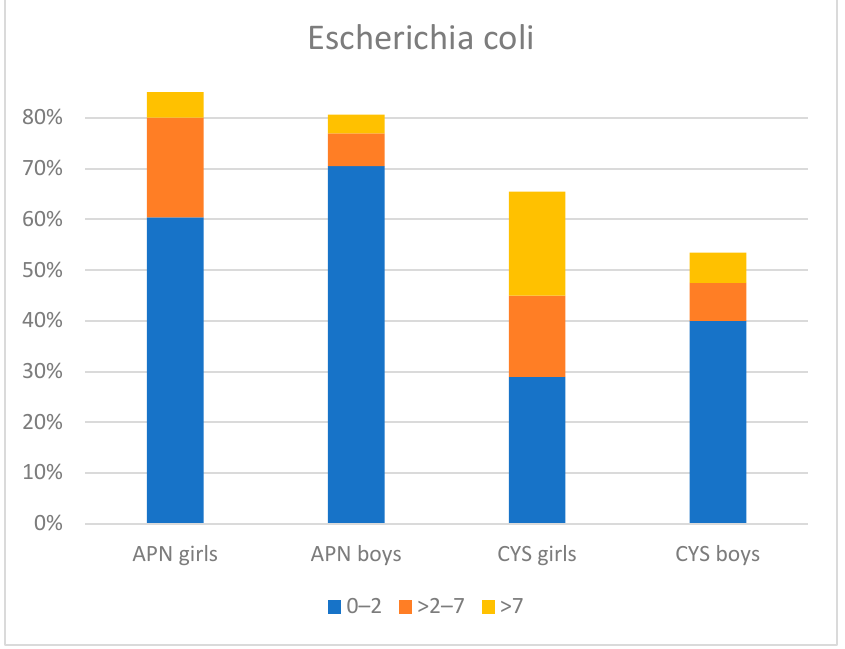
Figure 3. Distribution of E. coli strains according to sex, age, and type of UTI. APN; acute pyelonephritis, CYS; cystitis.